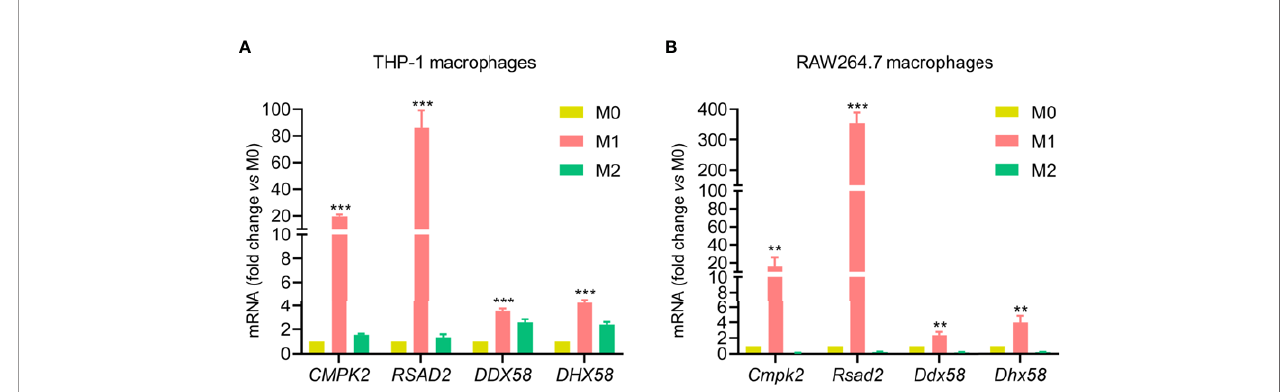
FIGURE 6 | Validation of commonly up-regulated proteins in M1 for both cell lines. Validation of CMPK2, RSAD2, DDX58, and DHX58 mRNA expression in M0, M1 and M2 phenotypes from human THP-1 (A) and mouse RAW264.7 macrophages (B) by qPCR. Expression relative to M0 macrophages. All data are presented as mean ± SEM, n = 3. ** P < 0.01, *** P < 0.001, compared with M0